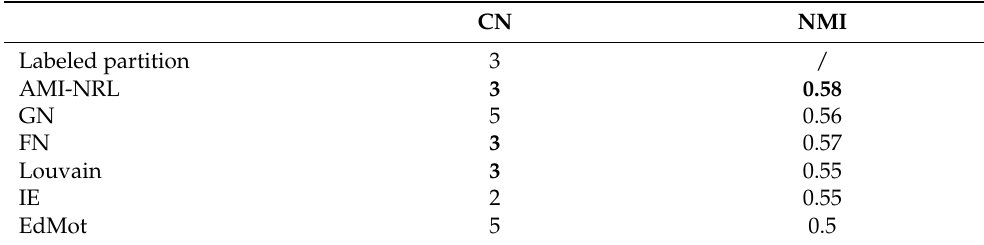
Table 4. Results of AMI-NRL and the other community detection algorithms on Polbooks.